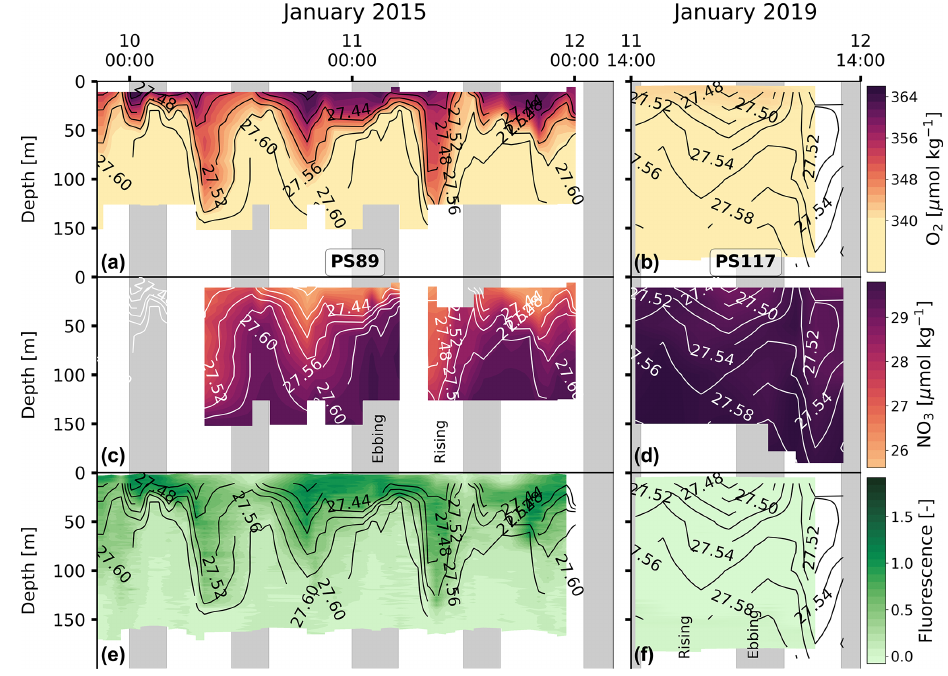
Figure 6. The same as Fig. 3 but for dissolved O 2 (a, b) , NO − < 0 .